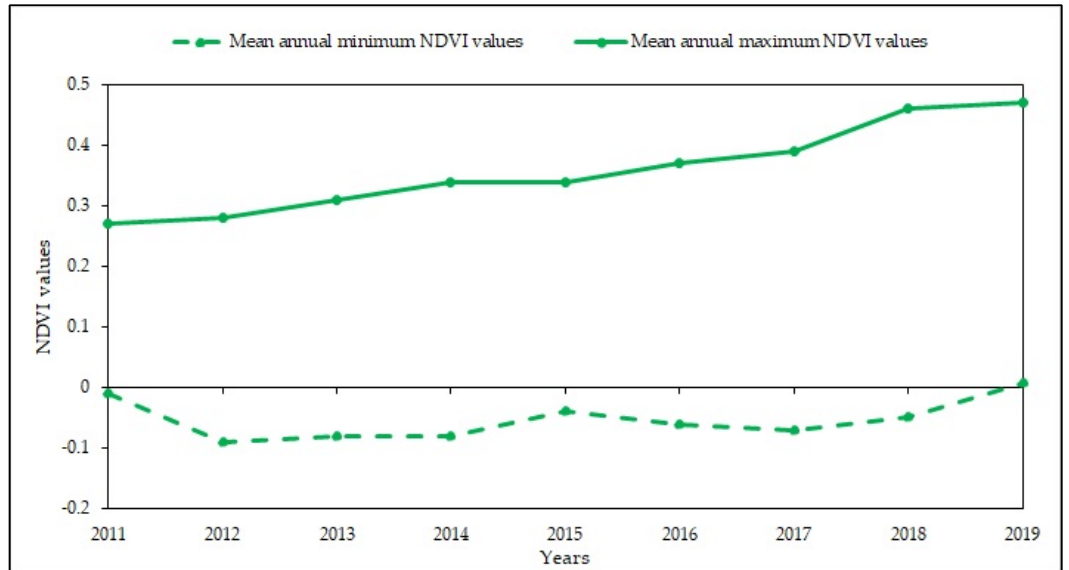
Figure 6. Spatial annual maximum and minimum values of the Normalized Difference Vegetation Index (NDVI) on Lake Tana starting from January 2011 to November 2019.